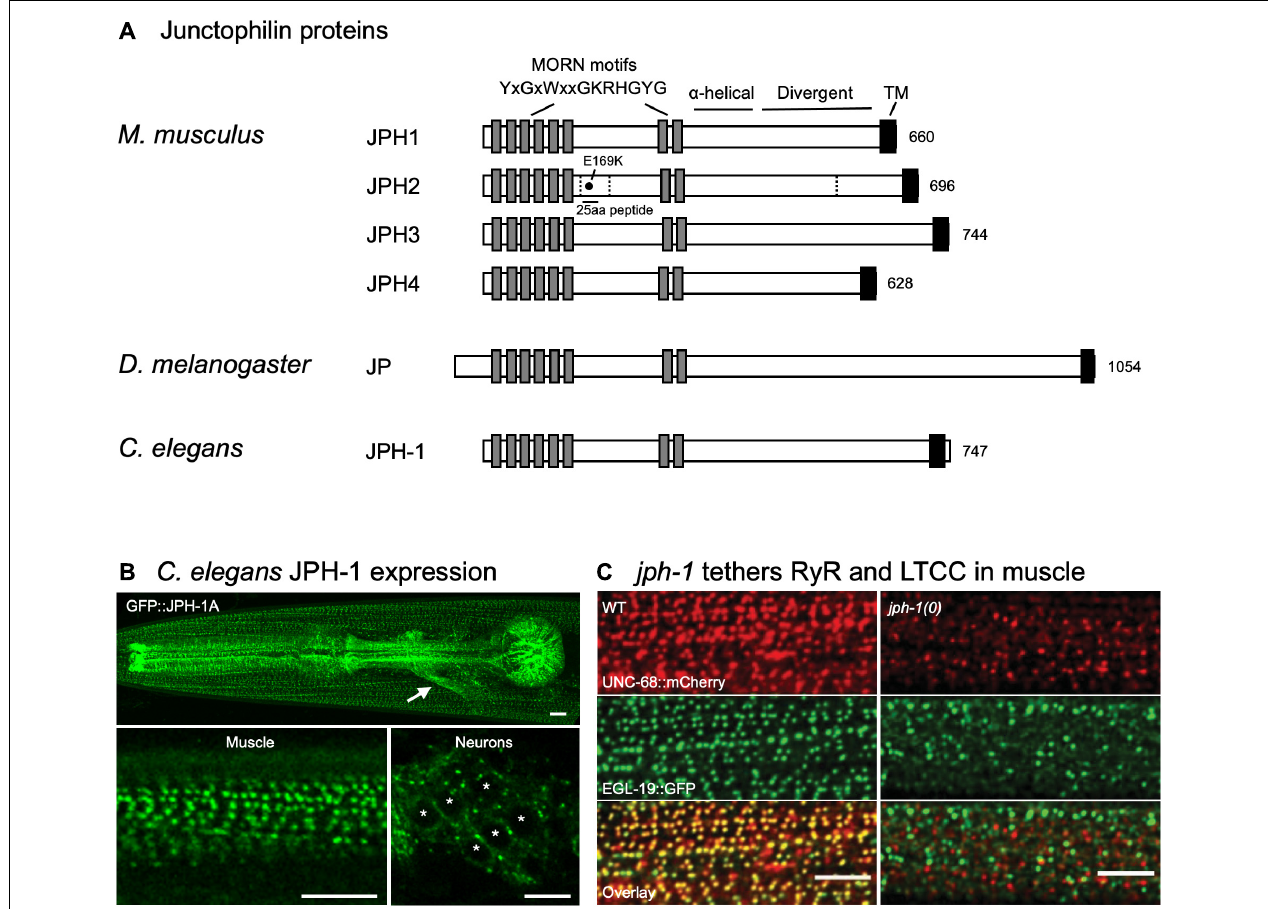
FIGURE 1 | Domain structures of junctophilin proteins and C. elegans junctophilin localization and function. (A) Domain structures of the four Mus musculus (mouse) junctophilins and sole members in Drosophila melanogaster (fly) and Caenorhabditis elegans (worm). Dashed lines indicate JPH2 cleavage sites. E169K mutation blocks binding to RyR and a 25 aa peptide flanking E169 prevents spontaneous RyR channel opening. Gene accession numbers are: M. musculus JPH1 (NP_065629.1), M. musculus JPH2 (NP_001192005.1), M. musculus JPH3 (NP_065630.1), M. musculus JPH4 (NP_796023.2), D. melanogaster Jp (NP_523525.2), and C. elegans JPH-1 (NP_492193.2). (B) Expression of GFP-tagged JPH-1 shows localization to JMCs in C. elegans muscles and neurons. Top: Head of a C. elegans animal showing GFP::JPH-1 in the pharyngeal muscle and body wall muscle. The white arrow indicates GFP::JPH-1 expression in a bundle of neuronal processes known as the nerve ring. Bottom left: In body wall muscle, JPH-1 localizes to rows of puncta, each one a JMC. Bottom right: In neurons, JPH-1 labels JMCs that form at the periphery of the soma. White asterisks mark neuronal nuclei. (C) jph-1 is required for the co-localization of UNC-68/RyR and EGL-19/LTCC in body wall muscle. jph-1(0) is a complete knockout. Scale bars, 5 µ m. Panels (B,C) reproduced from Piggott et al.